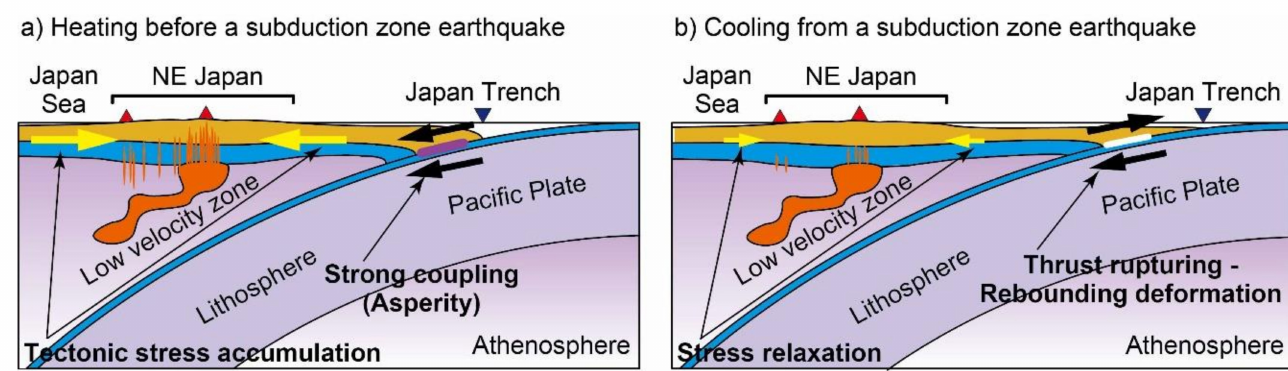
Figure 6. A conceptual model showing active basaltic magma rises before a large-scale subduction zone earthquake and inactive basaltic magma rises after the earthquake. ( a ) A heating process before a subduction zone earthquake: the accumulating tectonic stress by strong coupling on the asperity accelerates the rising of pumping basaltic magma. ( b ) A cooling process from a subduction zone earthquake: thrust rupture relaxation decelerates the rising of pumping basaltic